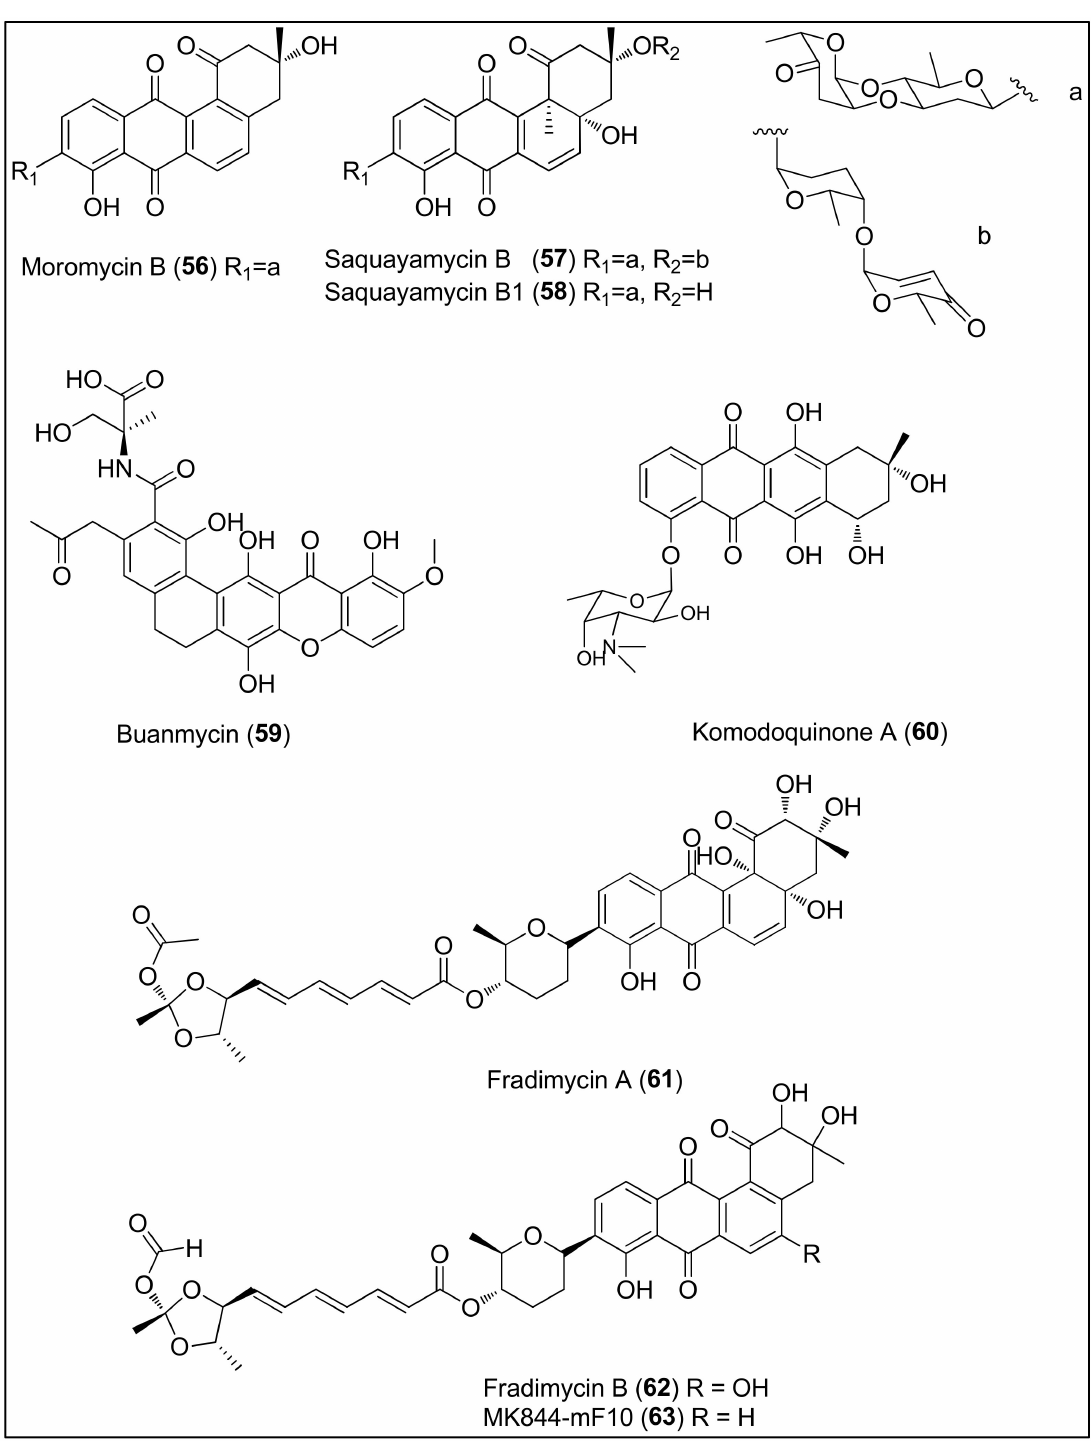
Figure 6. Chemical structures of moromycin B ( 56 ), saquayamycins B ( 57 ) and B 1 ( 58 ) isolated from the Streptomyces sp. OC1610.4 strain, buanmycin ( 59 ), isolated from the Streptomyces strain, SNR69, komodoquinone A ( 60 ), isolated from the Streptomyces sp. KS3 strain and fradimycin A ( 61 ), fradimycin B ( 62 ) and MK844-mF10 ( 63 ), isolated from the Streptomyces fradiae strain